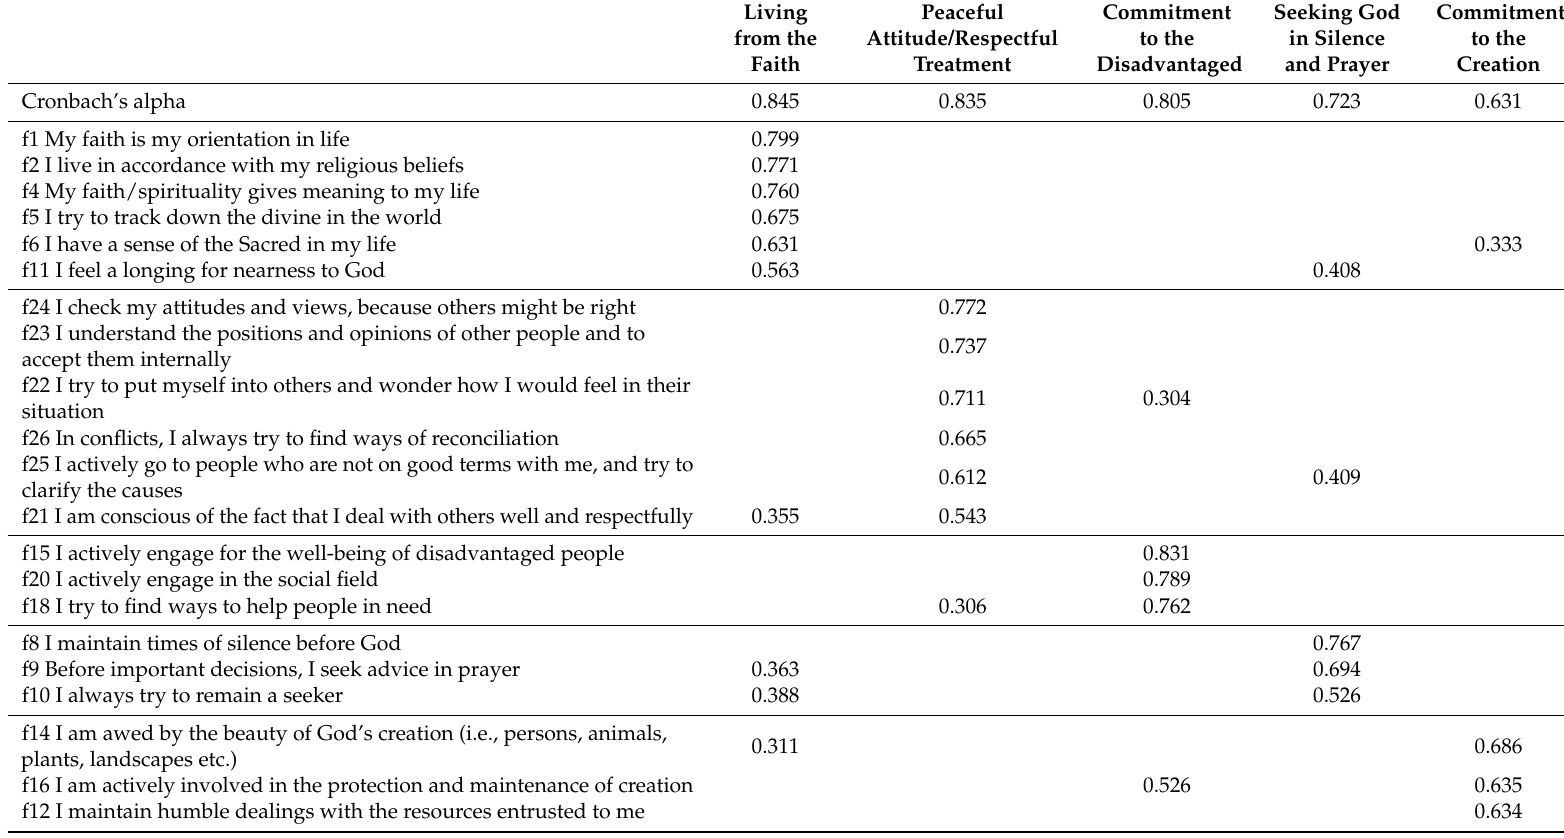
Table 1. Factorial structure of the FraSpir RO (Franciscan Spirituality—religious orders) questionnaire in this sample.